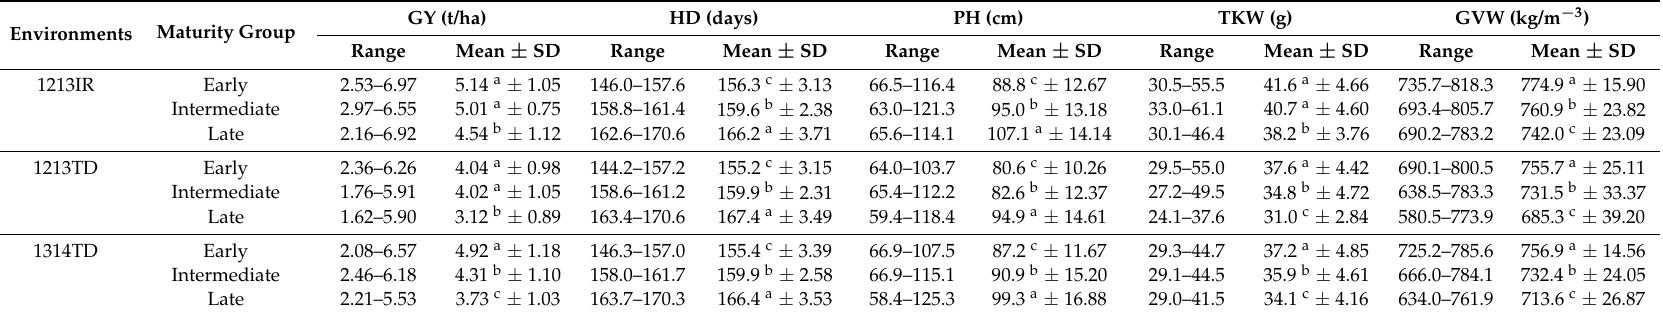
Table 3. Mean value ± standard deviation (SD) of traits investigated among winter wheat of three maturity groups in three